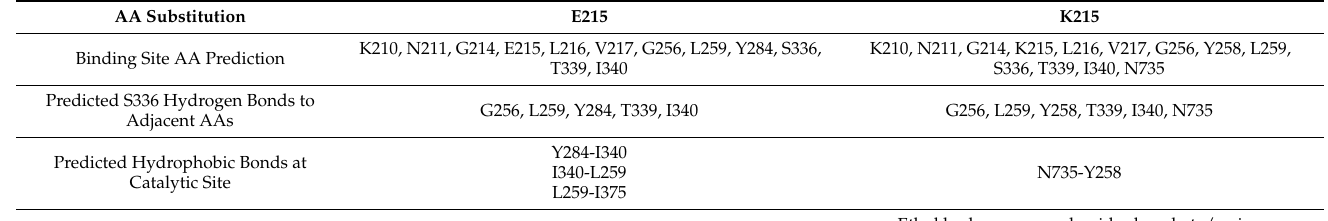
Table 2. Ligand-binding site identification and ligand-preference prediction. CestB 3D models for both types of amino acid substitutions were analyzed using the Coach-D algorithm to find the amino acids that constitute the ligand-binding site, additionally the ligand preference prediction was obtained during the analysis and summarized.